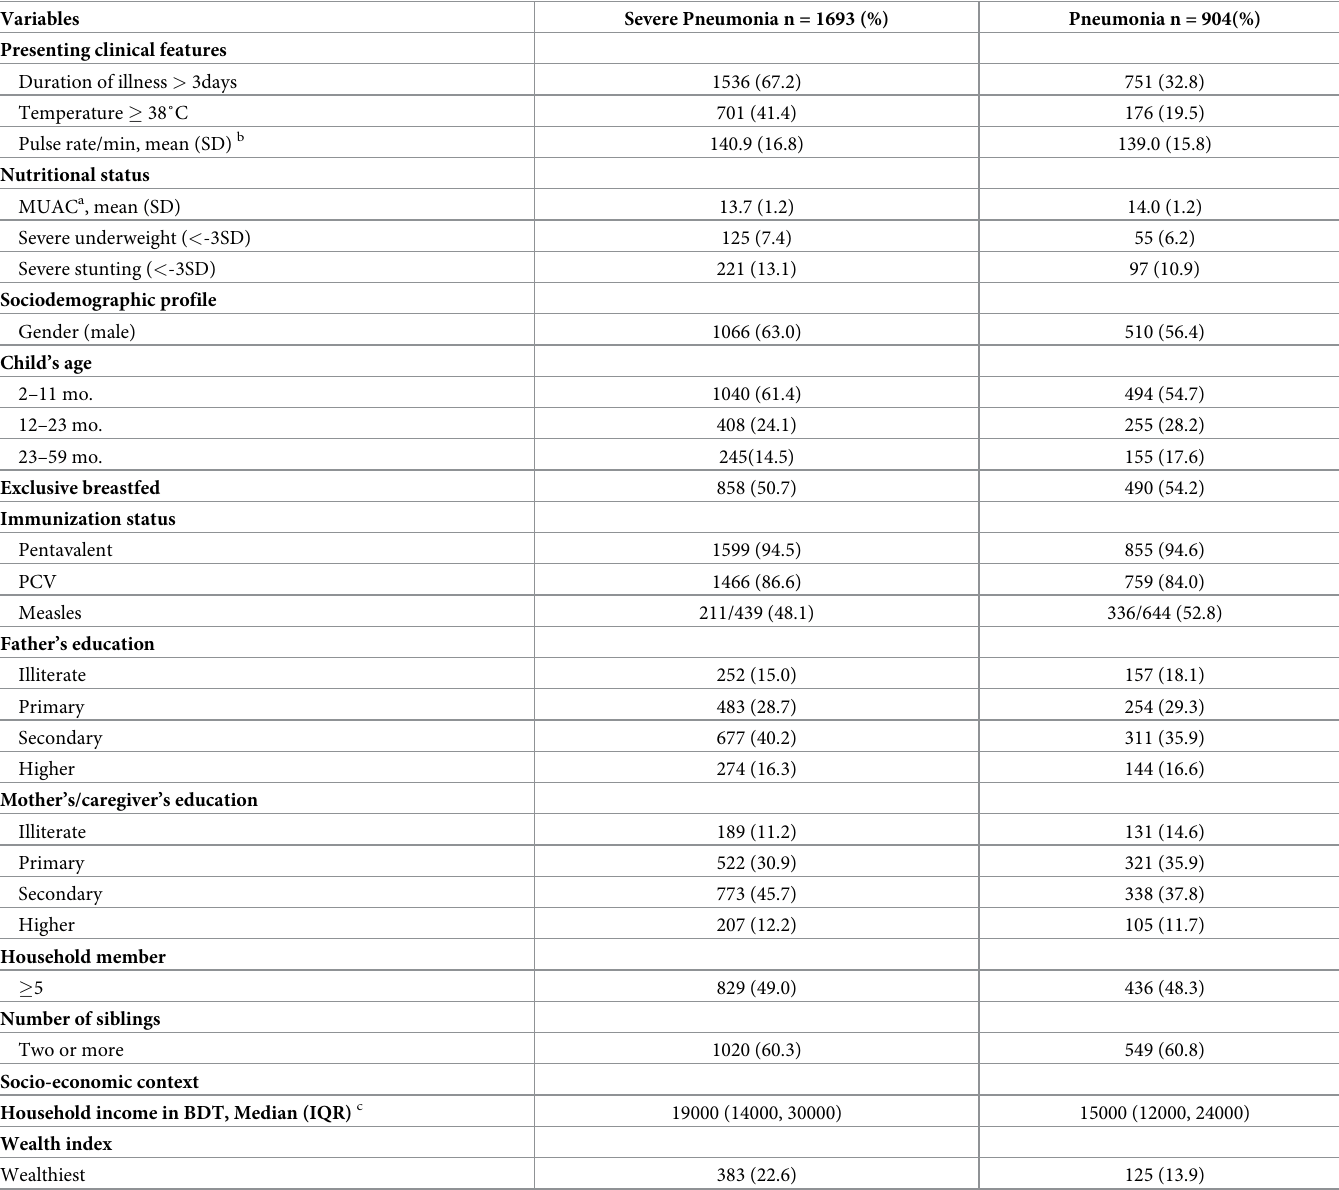
Table 1. Comparison of characteristics of the study population with severe pneumonia (cases) and pneumonia (controls) according to the WHO classification1. Variables Severe Pneumonia n = 1693